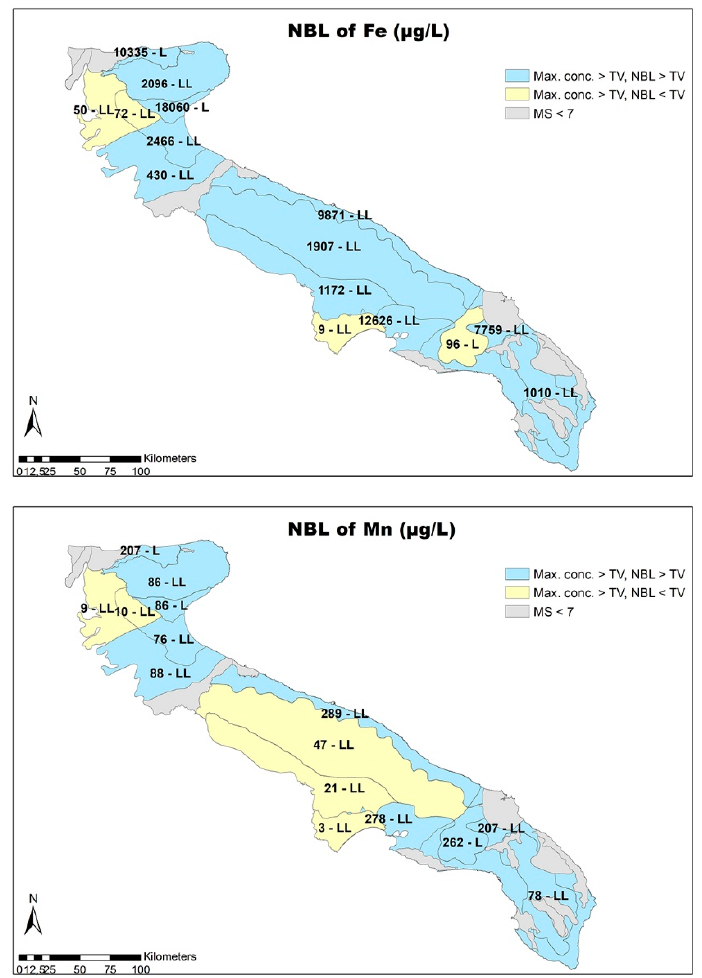
Figure 7. NBLs defined for iron and manganese at the GWBs scale and the associated confidence levels (L = low, LL = very low). In grey are shown the GWBs where the NBL assessment was not performed (MS < 7).